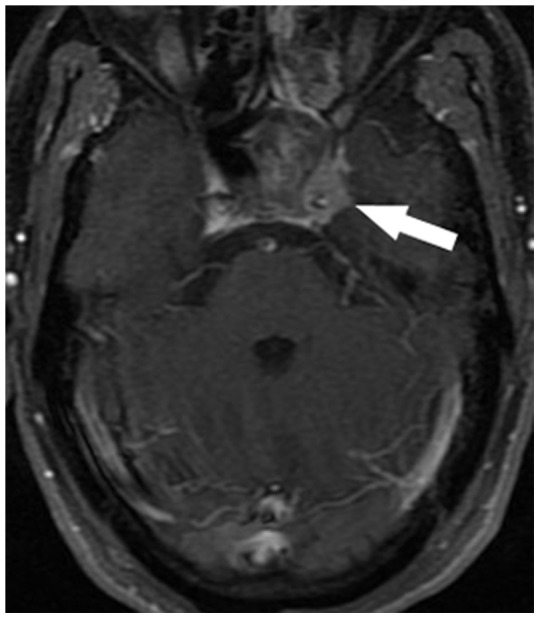
42-year-old man with nasopharyngeal carcinoma with cranial nerve invasion: enhanced axial T1-weighted image with fat suppression shows tumor invasion in the left cavernous sinus (arrow).